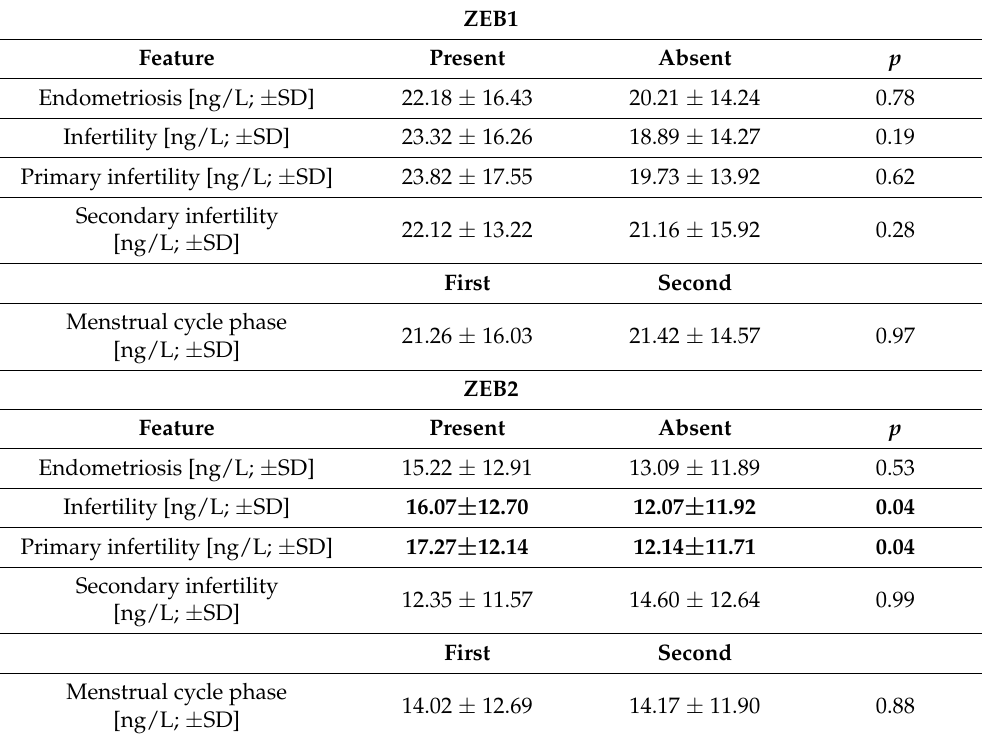
Table 1. Zinc finger E-box-binding homeobox 1 (ZEB1) and Zinc finger E-box-binding homeobox 2 (ZEB2) plasma